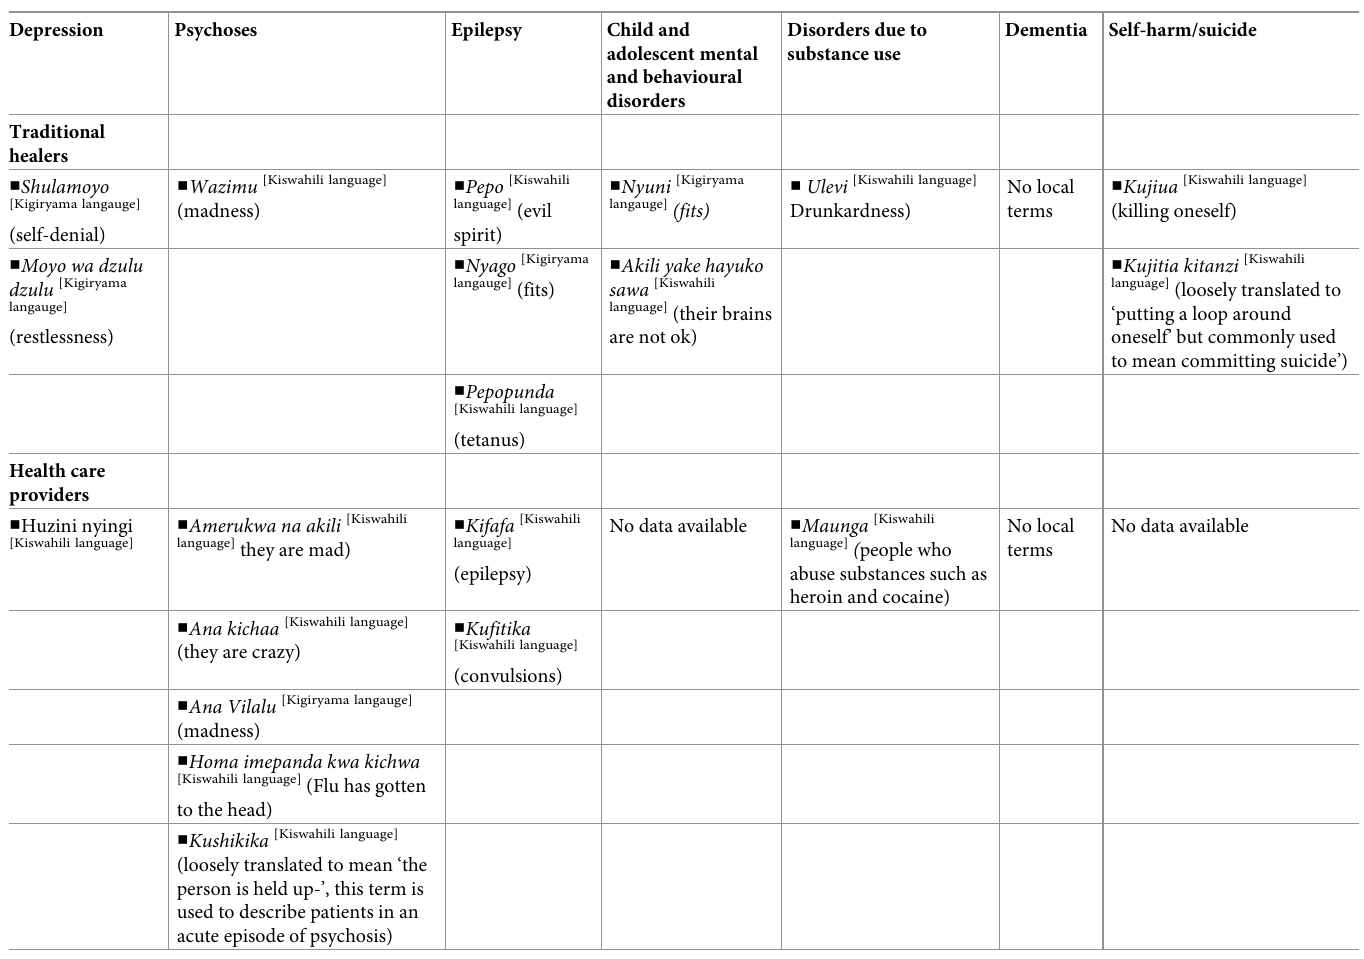
Table 1. Local terms for common mental